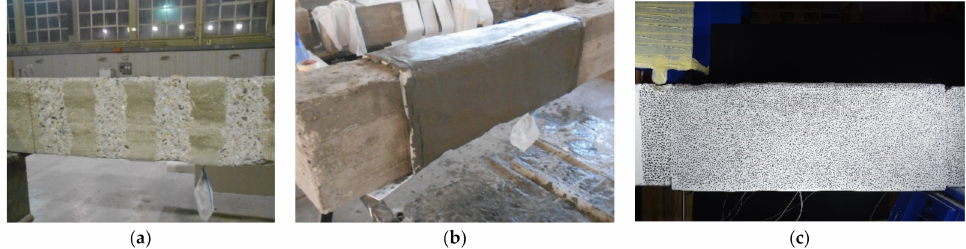
Figure 4. Beam strengthened preparation: ( a ) after the sandblasting; ( b ) after the casting of the external reinforcement; and ( c ) speckle pattern on the